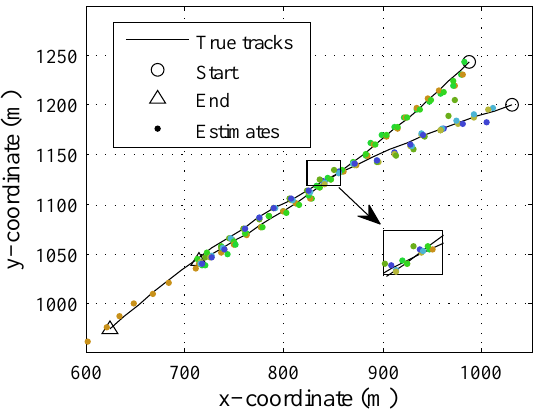
Figure 3. The true trajectory and estimated trajectory before applying the proposed method.